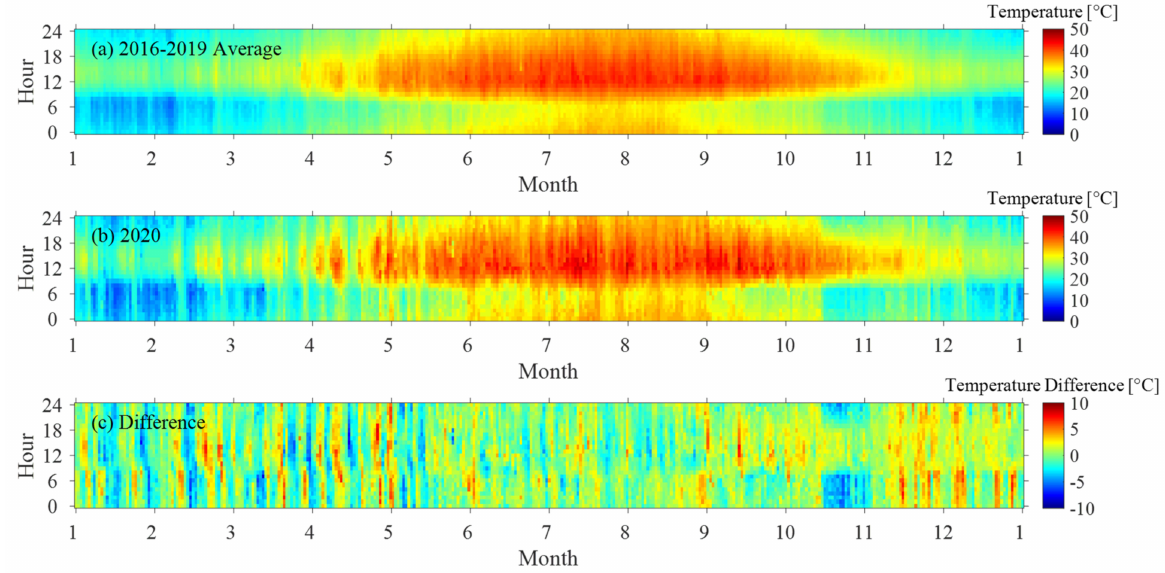
Figure 3. Sharjah City hourly temperature data presented using ( a ) average hourly temperature between 2016 and 2019, ( b ) hourly temperature in 2020, and ( c ) the hourly temperature difference between 2020 and the average of previously reported